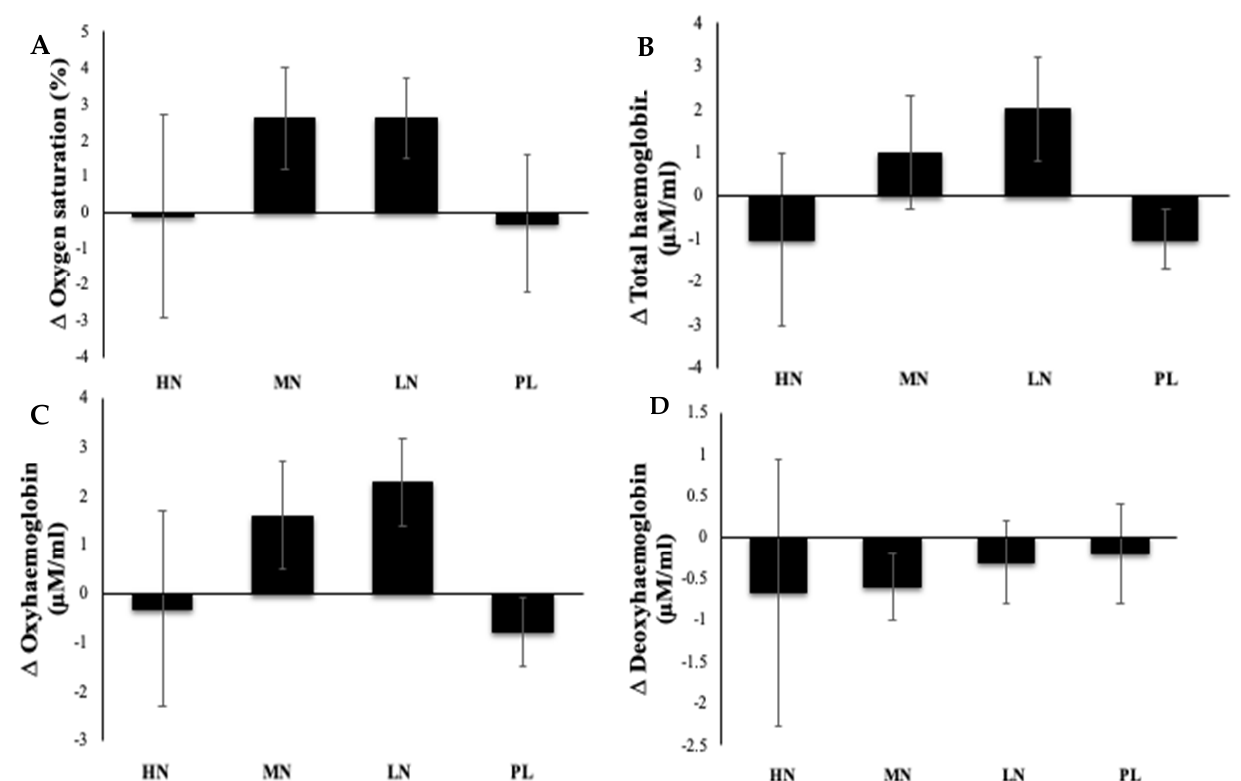
Figure 3. Prolonged effect of incremental doses of supplemental NO 3 − in form of beetroot juice on cerebral oxygen saturation ( A ), total haemoglobin ( B ), oxyhaemoglobin ( C ), and deoxyhaemoglobin ( D ). HN, high nitrate; MN, medium nitrate; LN, low nitrate; PL, placebo. No significant differences between groups were found for any of the cerebral blood flow (CBF)-related parameters ( p > 0.05). HN (high NO 3 − ; two 70 mL shots of beetroot juice/day, morning and evening), MN (medium NO 3 − ; 70 mL of beetroot juice/day), LN (low NO 3 − ; 70 mL of beetroot juice every alternate days), and PL (placebo; 70 mL of NO 3 − -depleted beetroot juice every alternate days). Each shot of beetroot juice contains 400 mg of NO 3 − . Data represent the change of CBF parameters recorded when performing cognitive tasks at 13 weeks from the resting period at baseline and were analysed using a one-way ANOVA. Data are expressed as mean ± SEM, ( n = 47).